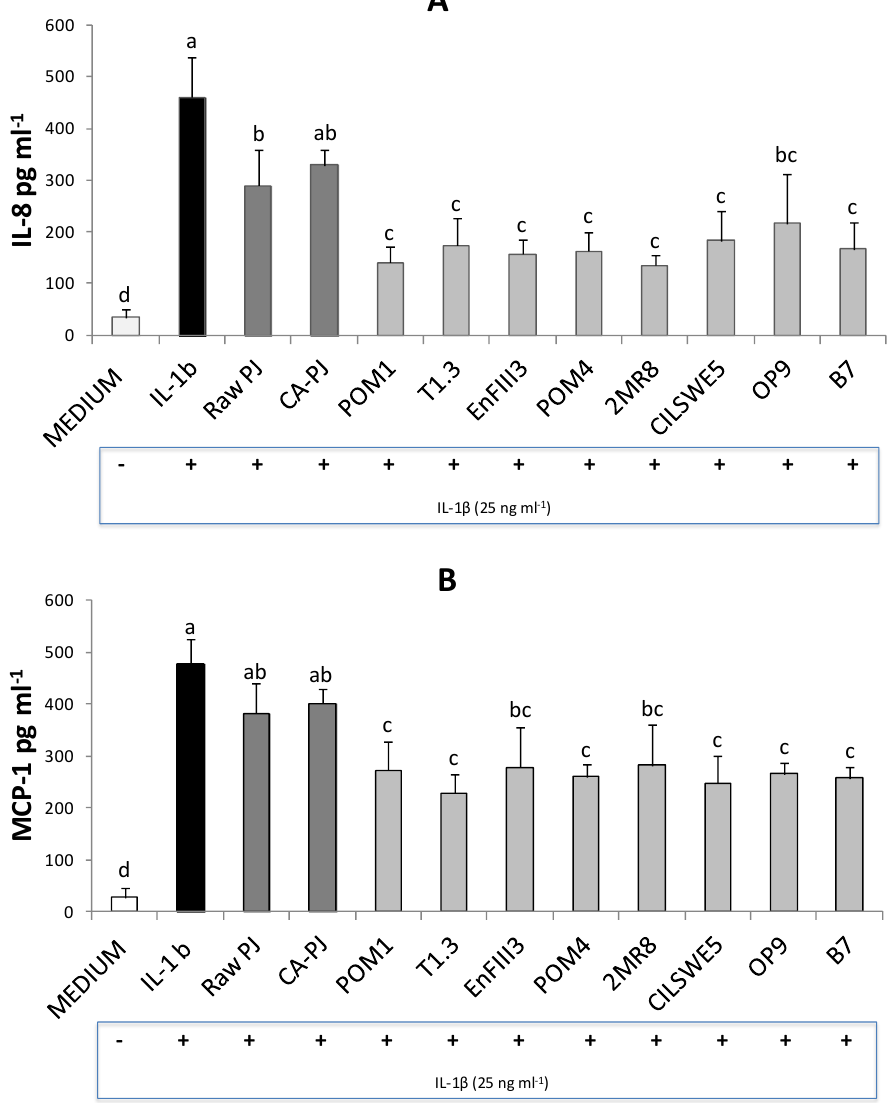
Figure 3. Interleukin-8 (IL-8) (A) and monocyte chemotactic protein-1 (MCP-1) (B) levels (pg mL − 1 ) measured in Caco-2 cells pretreated for 6 h with raw Portulaca oleracea L. juice (Raw-PJ), chemically acidified PJ (CA-PJ), and PJs fermented (30 °C for 36 h) by Lactobacillus plantarum POM1, T1.3, and EnFIII3, Lactobacillus brevis POM4, Lactobacillus rossiae 2MR8, Pediococcus pentosaceus CILSWE5, Leuconostoc mesenteroides OP9, and Lactobacillus kunkeei B7, then stimulated and treated with the inflammatory stimulus (Interleukin-1 β 25 ng mL − 1 ) for 24 h. Bars with different superscript letters differ significantly ( p < 0.05).